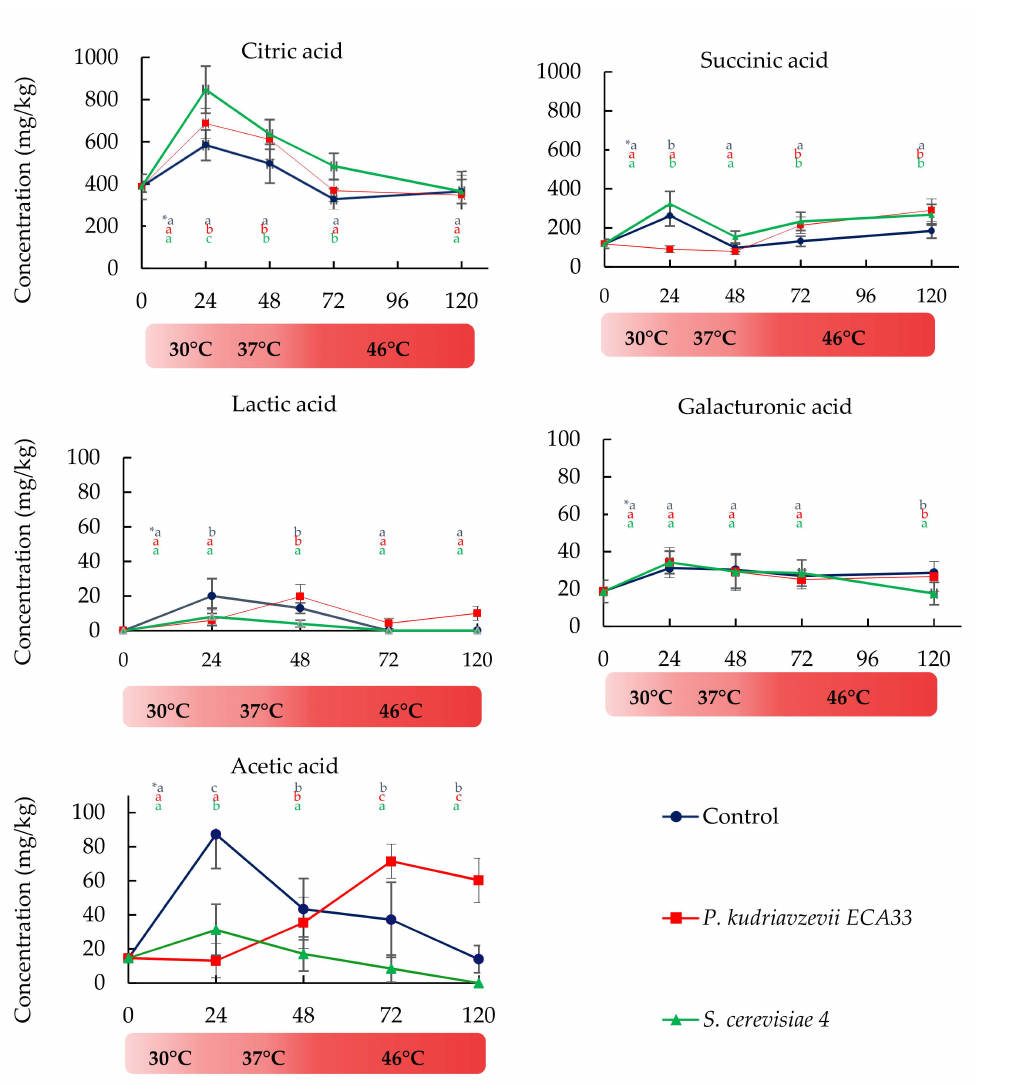
Figure 3. Citric acid, succinic acid, lactic acid, galacturonic acid, and acetic acid production during fermentation of P. kudriavzevii ECA33 (red line), S. cerevisiae 4 (green line) and uninoculated control (blue line). Data are expressed as mean ± standard deviation (SD) values from duplicate determinations. * Different letters in the same column (hour) indicate significant differences ( p < 0.05) among inoculated strains; first row control, second row P. kudriavzevii ECA33, and third row S. cerevisiae